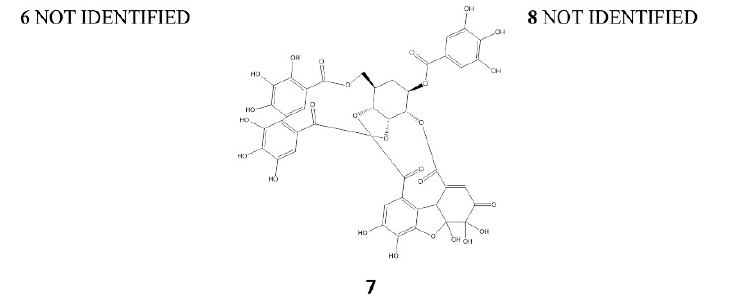
Figure 5. Structure of the main ellagitannins identified in A. chilensis leaf extracts. The structure 6 and 8 was not identified